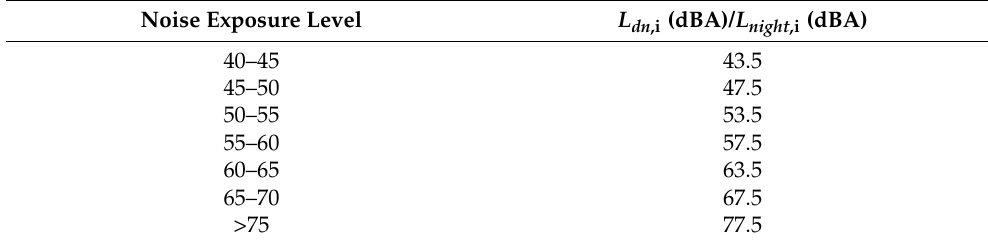
Table 8. The representative values corresponding to different noise exposure